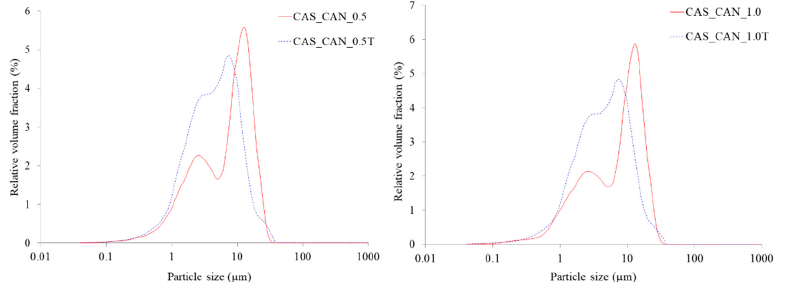
Figure 1. Droplet size distribution of film-forming emulsions containing candelilla wax at 0.5